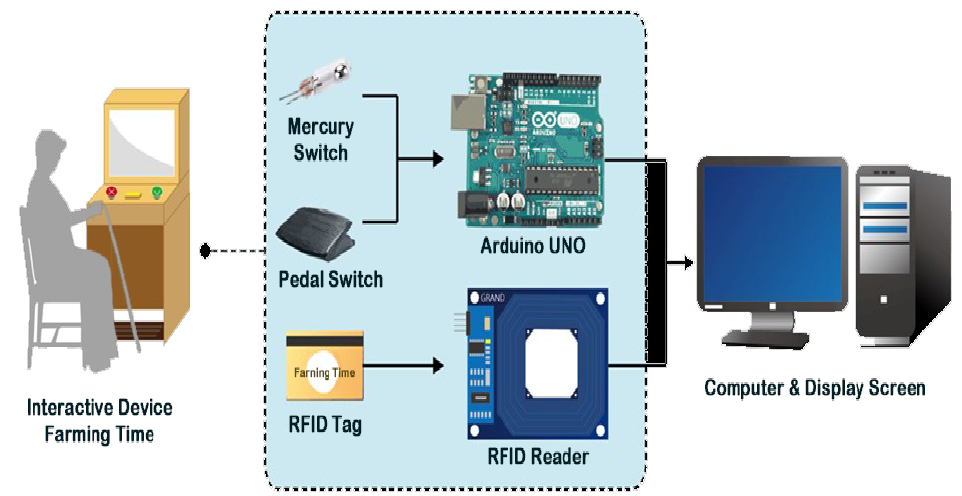
Figure 5. Architecture of the proposed interactive system “Farming Time.”.